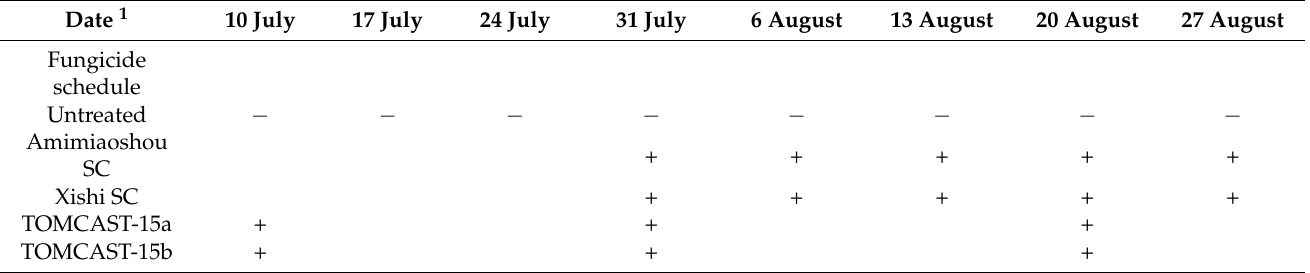
Table 3. Dates of spraying fungicide to control potato early blight during the experiment in